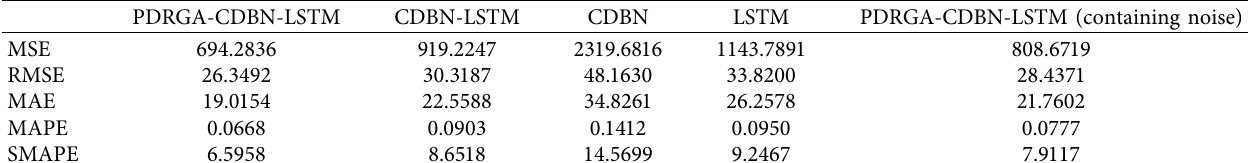
Table 6: Error evaluation indicator of each model using the PeMSD8 dataset.